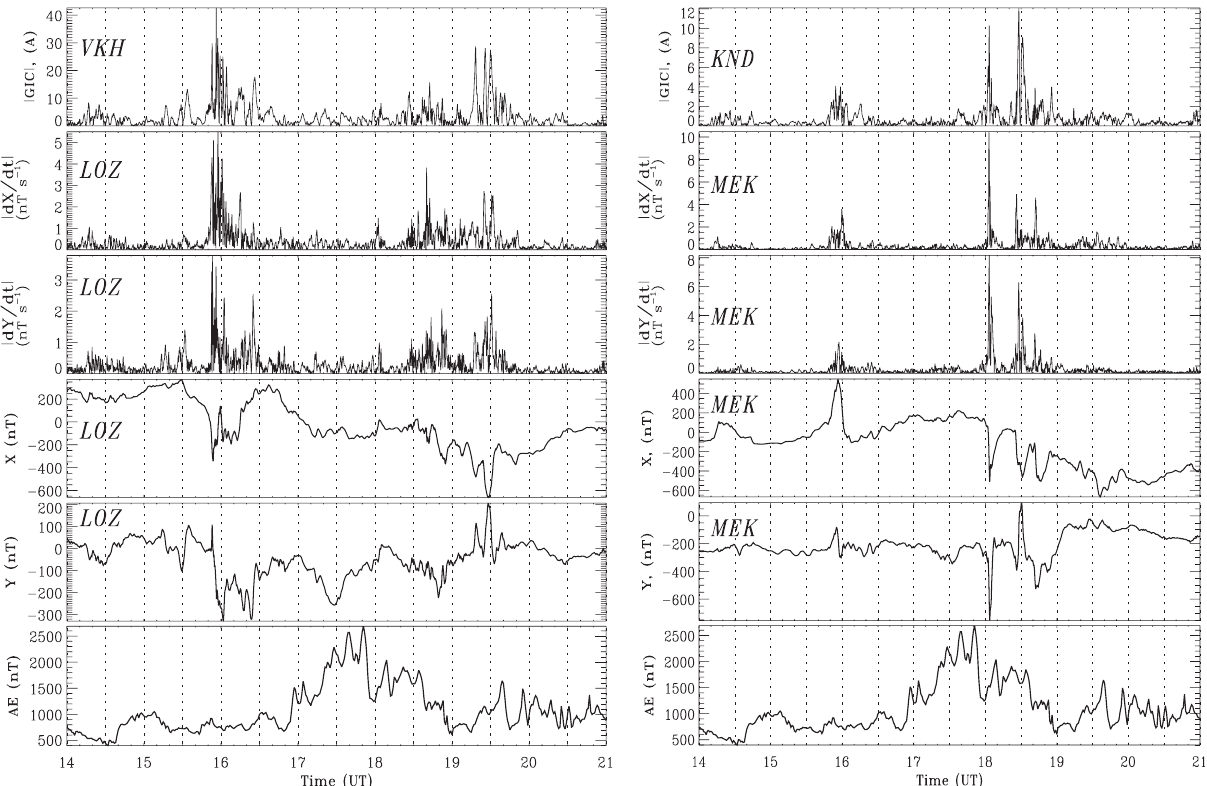
Fig. 8. (a) Comparison of GIC amplitudes [A], magnitudes of derivatives |dX/d t | and |d Y /d t | [nT s (cid:1) 1 ], and geomagnetic variations ( X - and Y -components) [nT] from nearby stations VKH and LOZ during 14 – 21 UT on 17 March 2013. The bottom panel shows variations of the 1-min AE index. (b) The same format for the KND-MEK